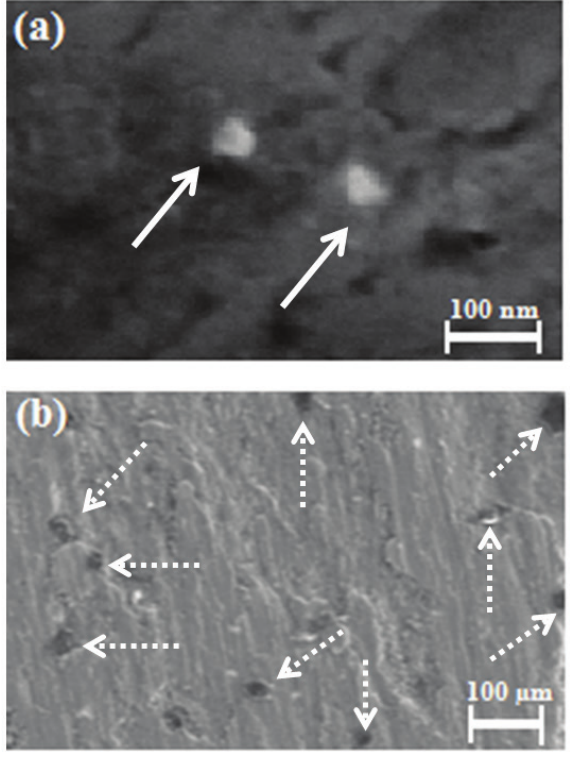
Figure 2: SEM images of the microstructures of (a) AMMNC sample with 1wt.% nano-sized Al 3.5wt.% micro-sized Al